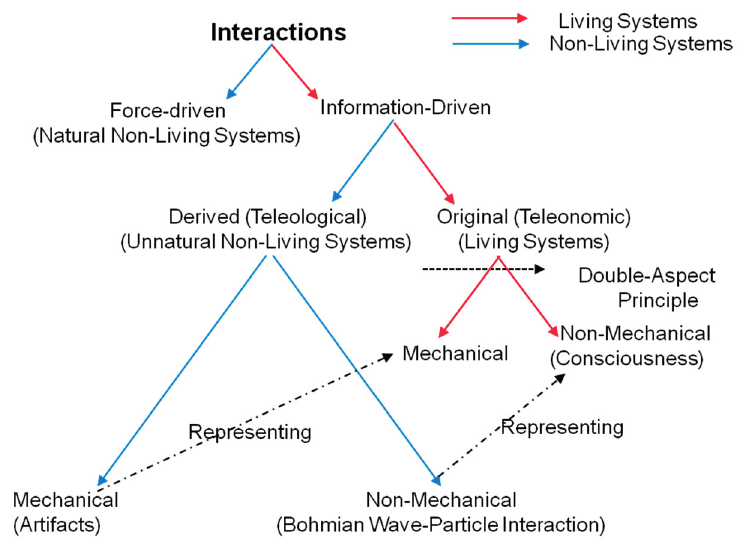
Figure 2. Two fundamentally different classes of interactions and their